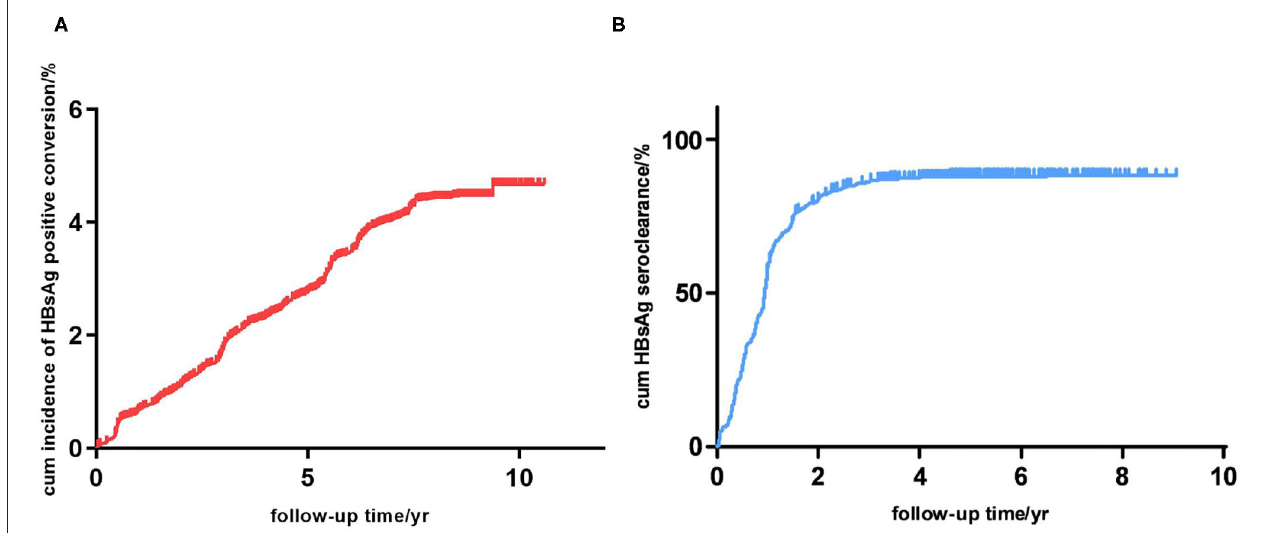
FIGURE 2 | (A) Cumulative incidence of new hepatitis B infection in this study cohort ( n = 151,926). (B) Cumulative incidence of HBsAg seroclearance in participants with hepatitis B infection ( n =